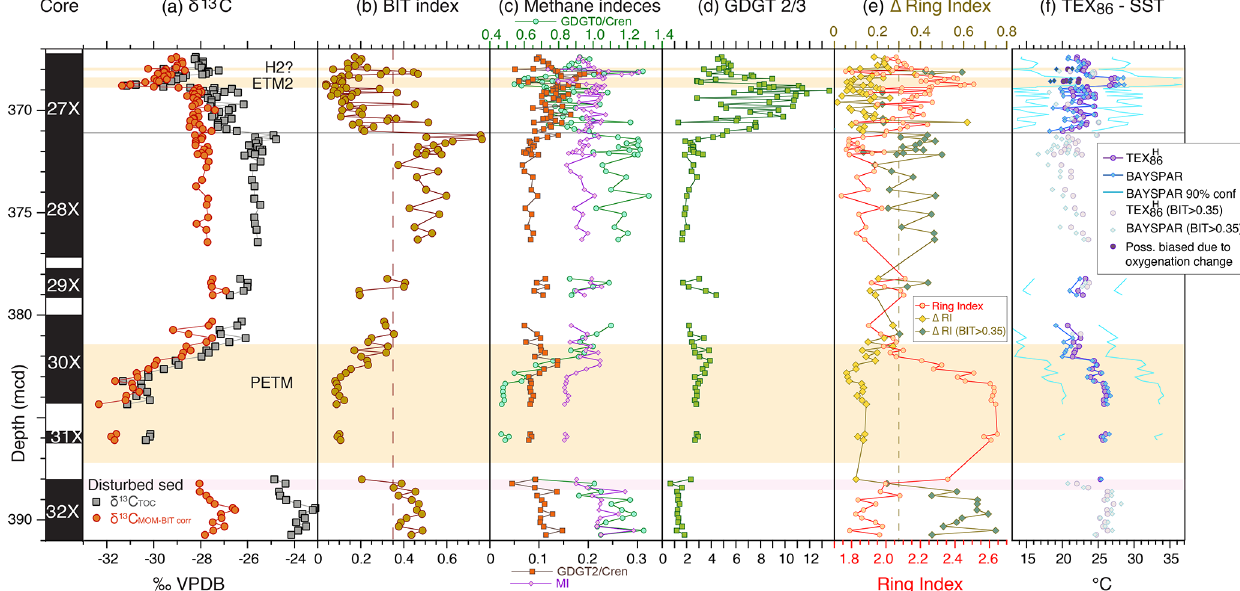
Figure 6. Branched and isoprenoid GDGT records across the upper Paleocene and lower Eocene of ACEX Hole 4A. (a) Carbon isotope stratigraphy (total organic carbon record from Sluijs et al., 2006, 2009; marine organic matter record from Sluijs and Dickens, 2012), (b) BIT index (Eq. 2), (c) indices indicative of anaerobic archaeal methanotrophy (MI (Eq. 3) and GDGT-2 / crenarchaeol) and methanogenesis (GDGT-0 / crenarchaeol), (d) GDGT-2 / GDGT-3 ratio, (e) ring index (Eq. 5) and D-ring index, and (f) TEX86 (Eq. 1) calibrated to sea surface temperature using a nonlinear calibration TEX H calibration (Kim et al., 2010) and the BAYSPAR method, which is based on a linear 86 calibration (Tierney and Tingley,